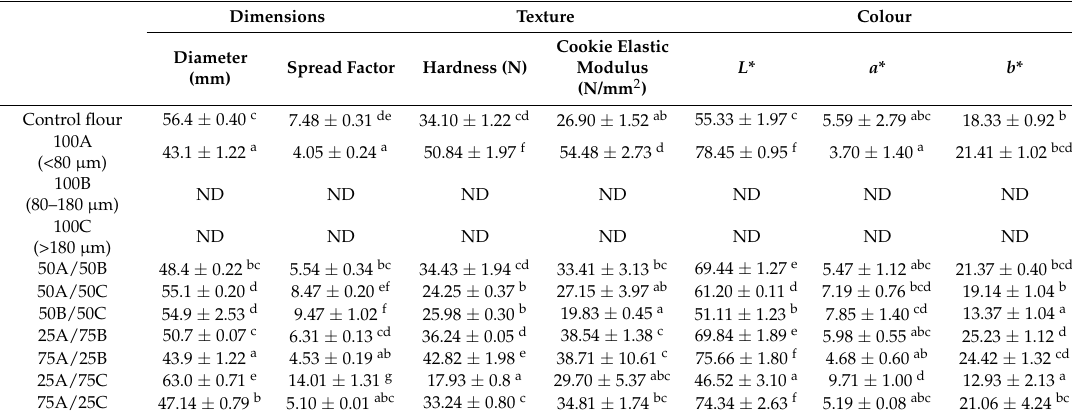
Table 4. Physical properties of